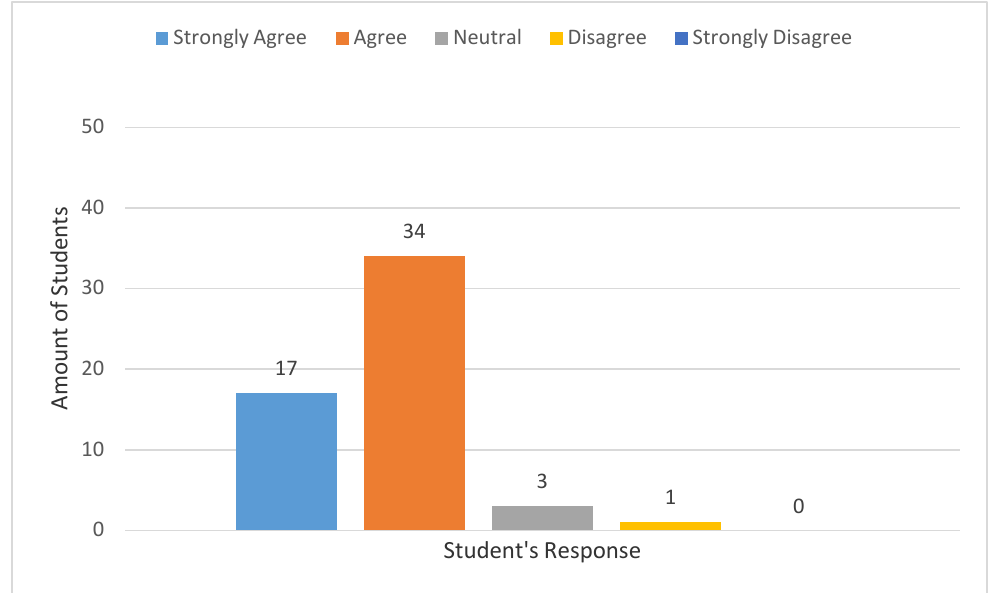
Figure 1. Student response to development opportunities and utilization of learning